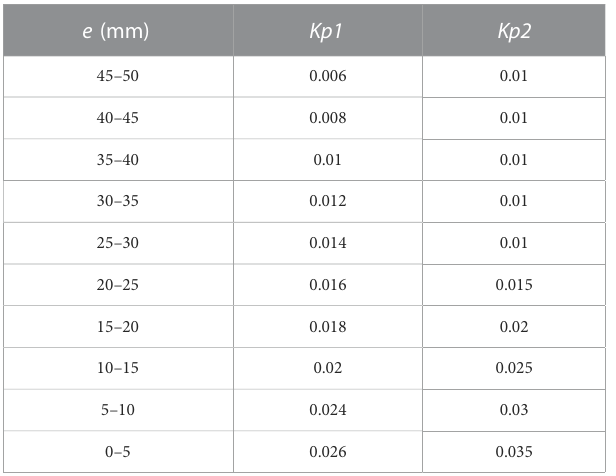
TABLE 3 Fuzzy controller parameter setting.